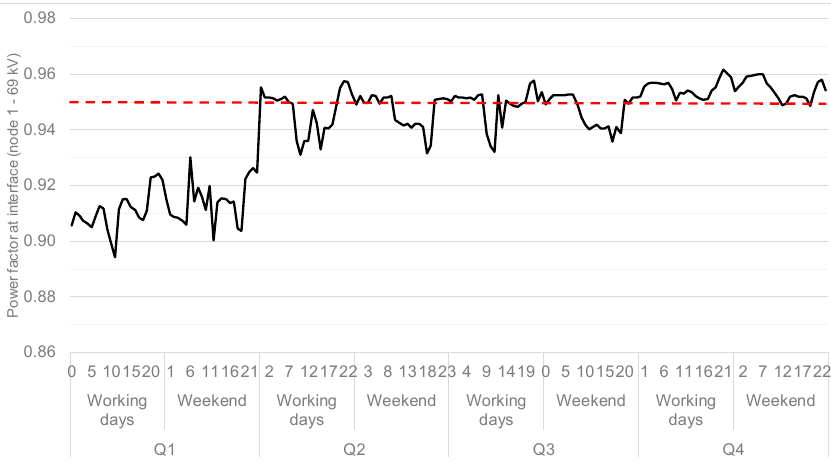
Figure 5. Case study: global power factor profiles in the different representative days.